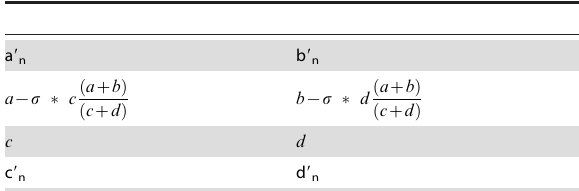
Table 5. Adjusted observed values when cases not present in a subgroup are